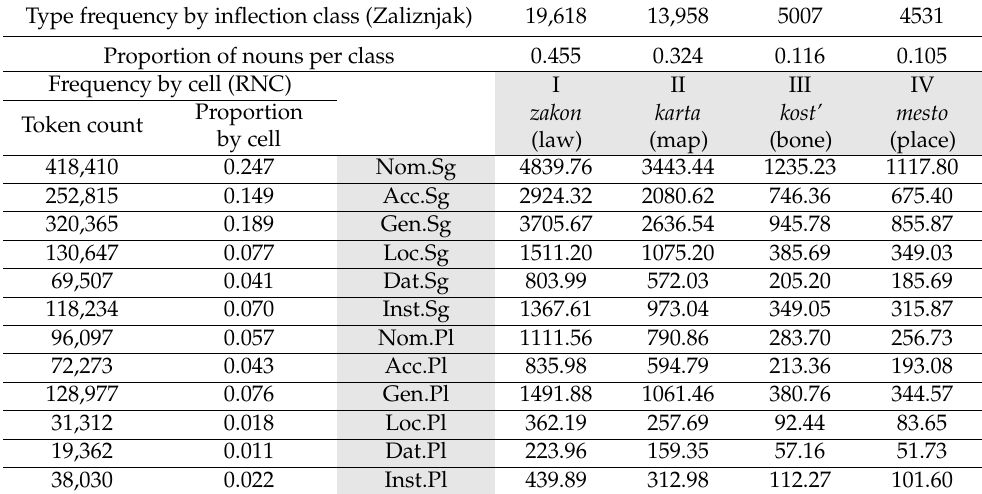
Table 5. Estimated frequency of each paradigm cell for Russian